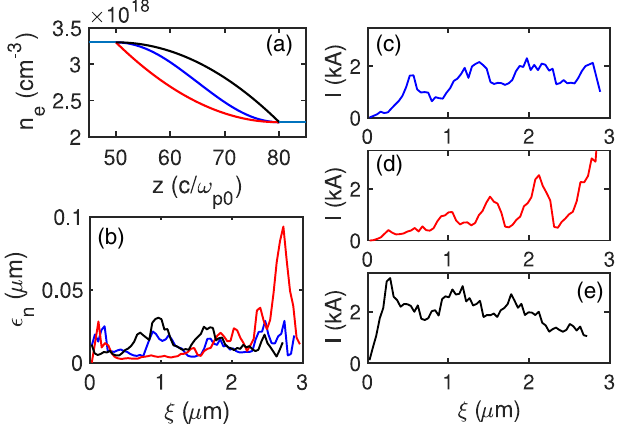
FIG. 6. Current profile and emittance of the injected beam for different ramp shapes. (a) Three different ramp shapes. (b) The normalized slice emittance of the injected beam for different ramp shapes. (c) – (e) Current profiles of the injected beams. In (b) – (e), the color of the lines corresponds to that in (a).